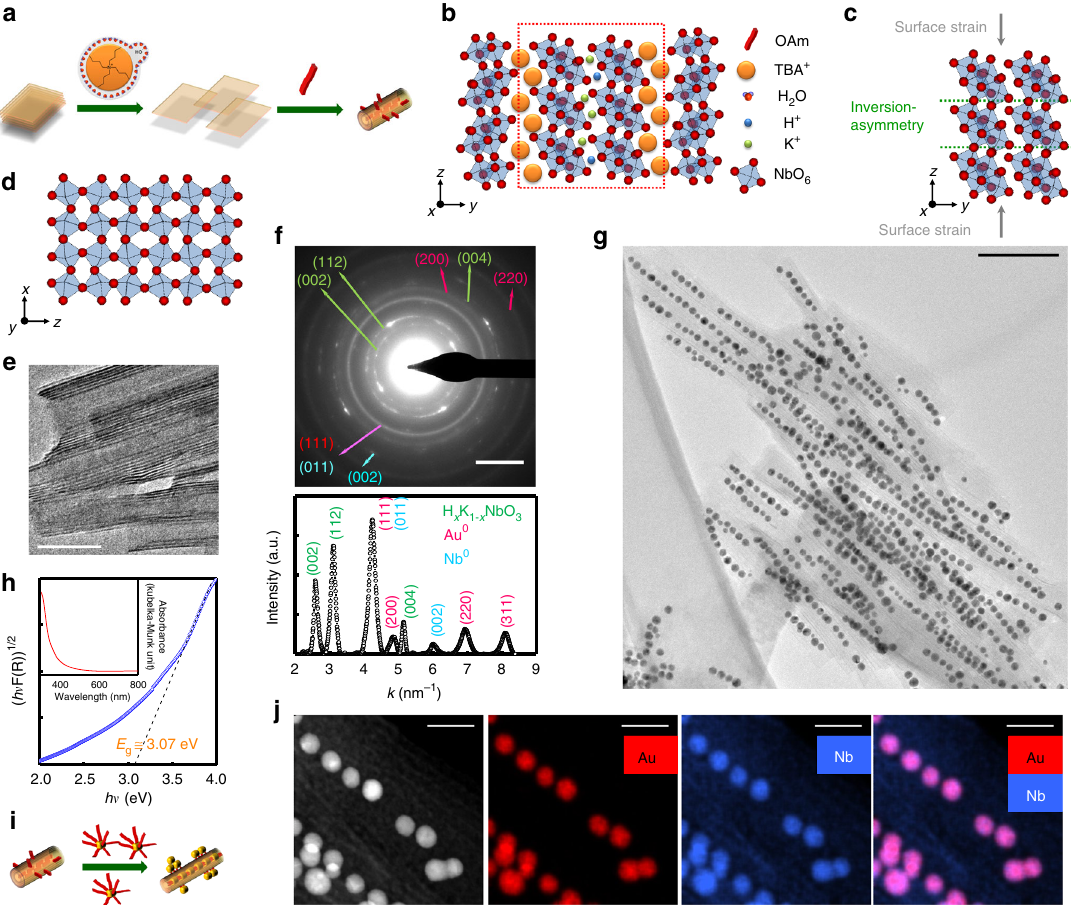
Fig. 1 Stepwise formation and characterization of Au@Nb@H x K 1 − x NbO 3 NPPs. a Schematic and b , c crystallographic illustrations of the morphological evolution of templated H x K 4 − x Nb 6 O 17 crystallites to lamellar and tubular colloids. d Crystal structure of cubic HNbO 3 perovskite. e TEM image (scale bar: 70 nm) of tubular H x K 1 − x NbO 3 NSs, in which the hollow cavity functions as the host to breed the Au@Nb CS-NPs. f SAED pattern (top, scale bar: 3